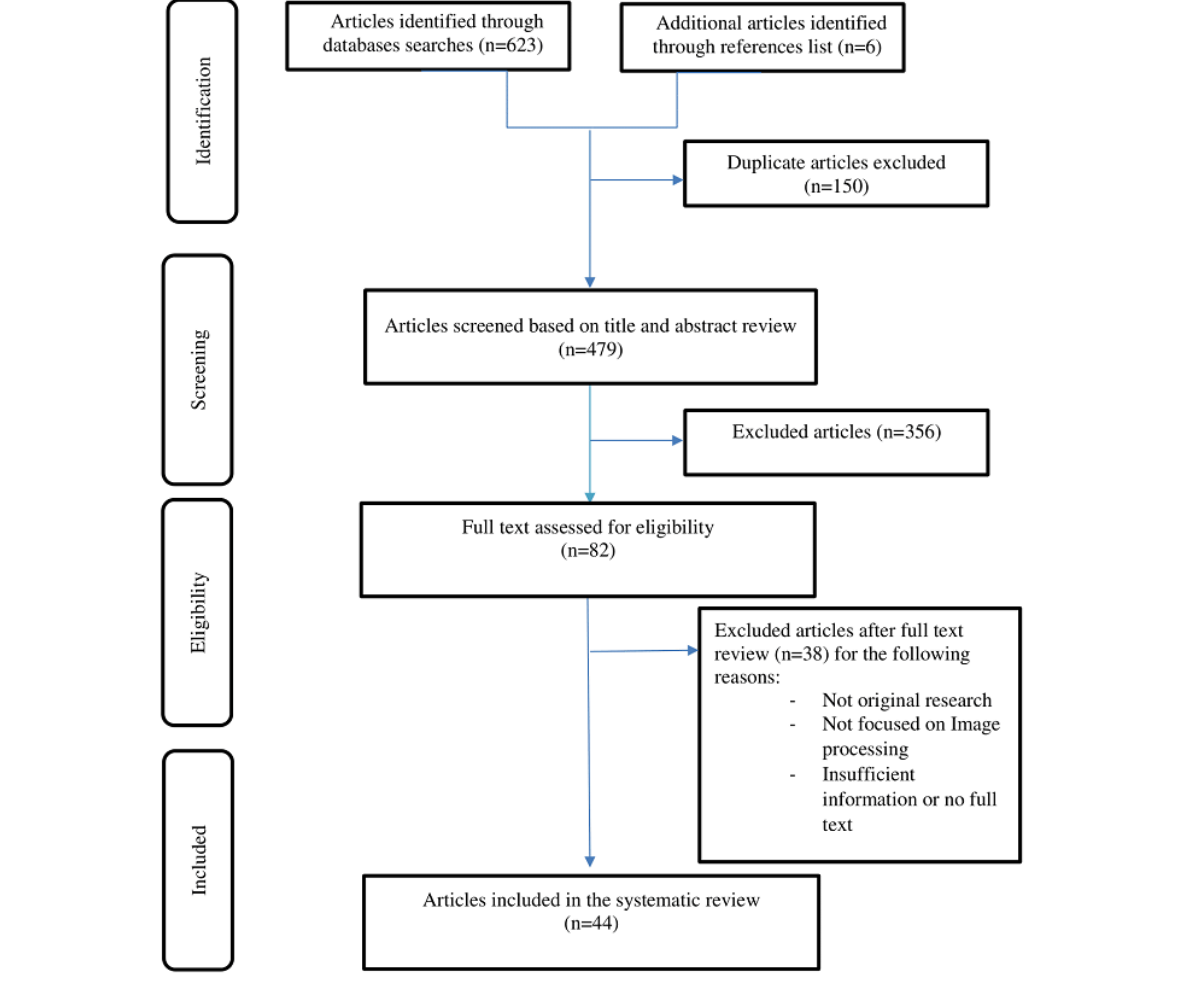
Figure 1. Study identification and selection